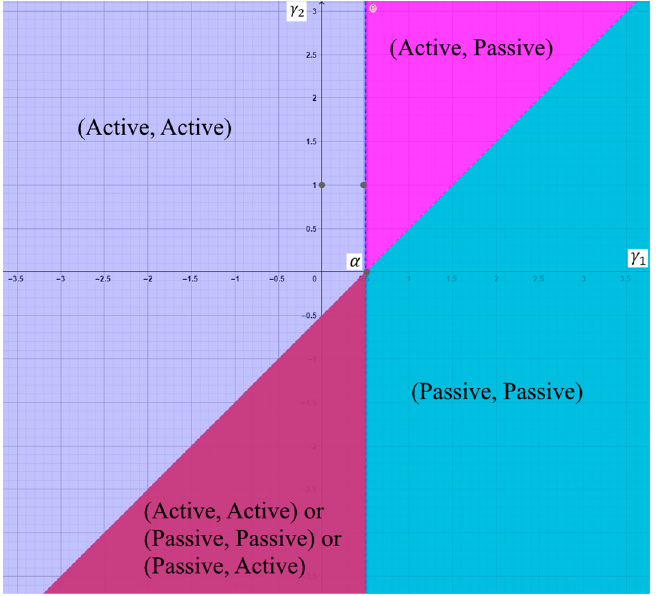
Figure 2. Nash equilibrium diagram for the 2 × 2 game between the Scrum Master and other team members with α , γ 1 and γ 2 parameters.